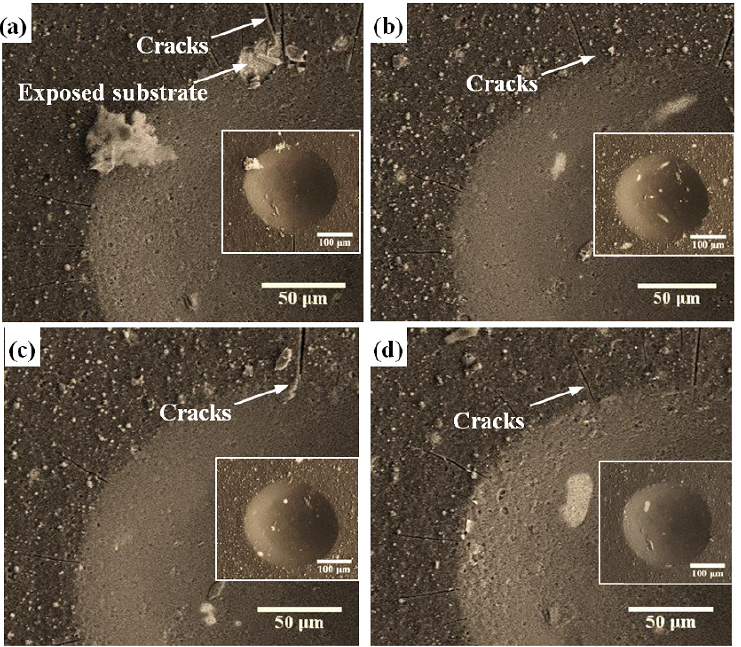
Figure 4. Indentations of ( a ) TiAlN/WT1, ( b ) TiAlN/WT2, ( c ) TiAlN/WT3 and ( d ) TiAlN/WT4 coated cemented carbides.